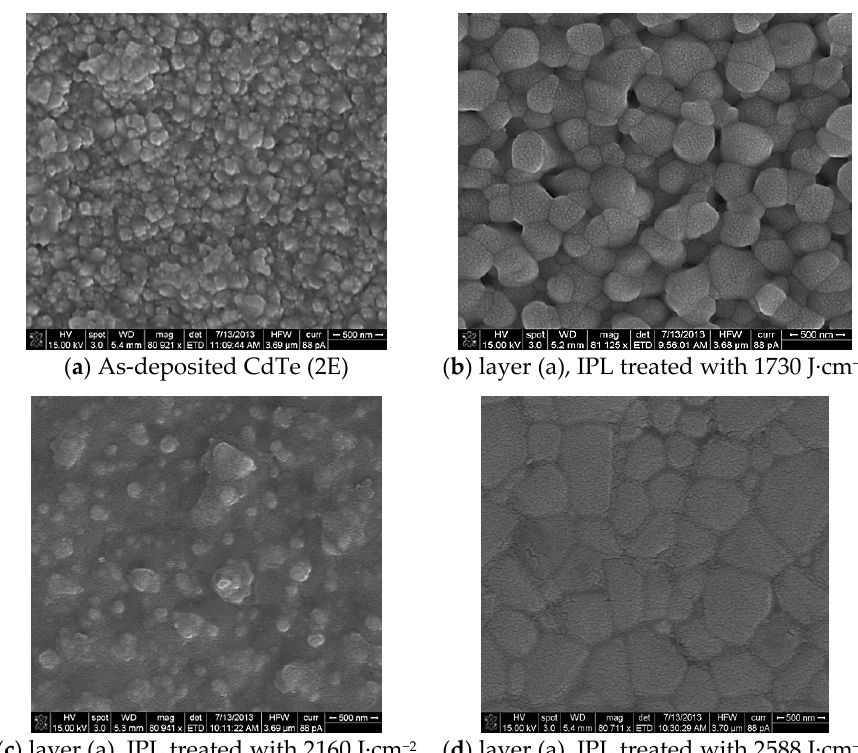
Figure 4. A typical SEM image of the as-deposited CdTe layer from the 2E system and changes of morphology as the energy input is increased using intense pulse light (IPL) treatment.